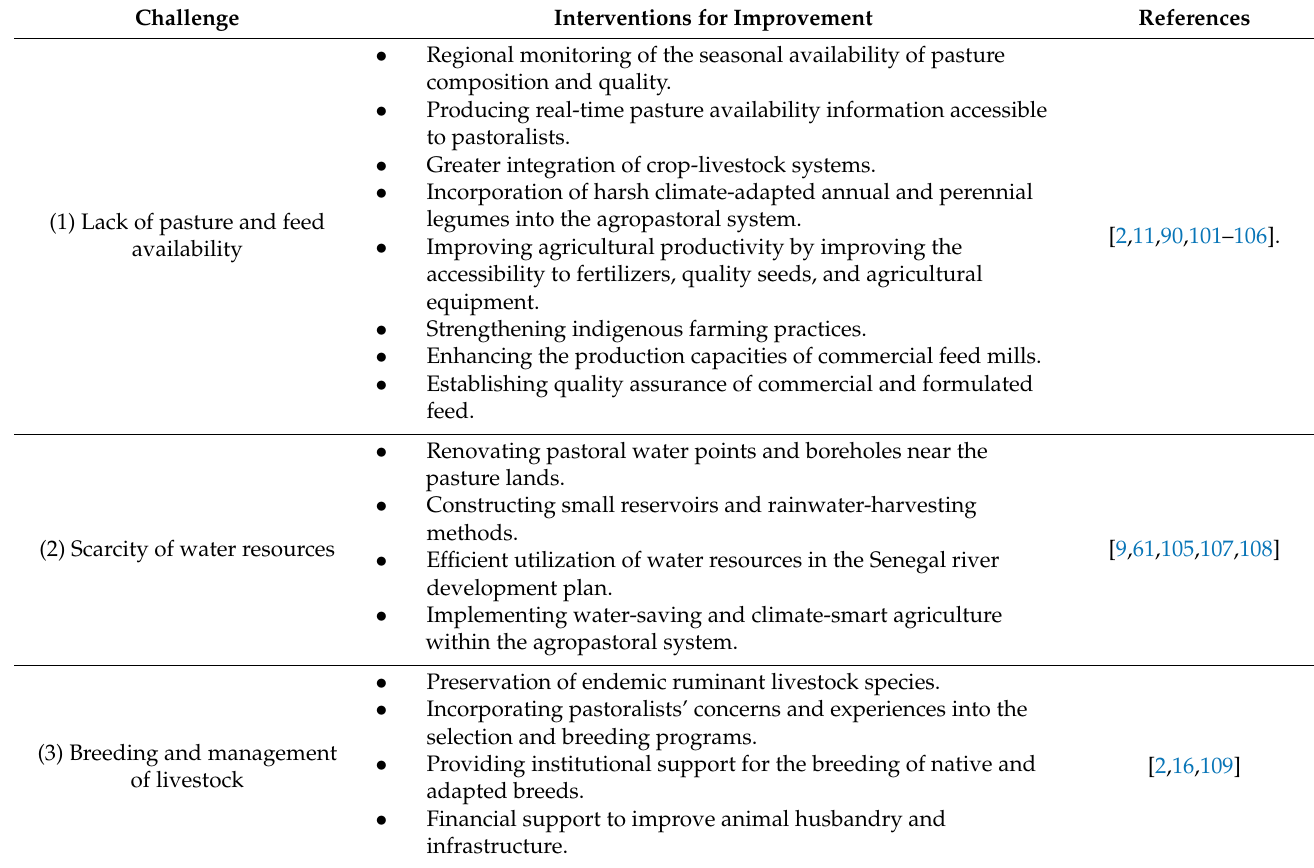
Table 2. Potential interventions to overcome the challenges of livestock farming in